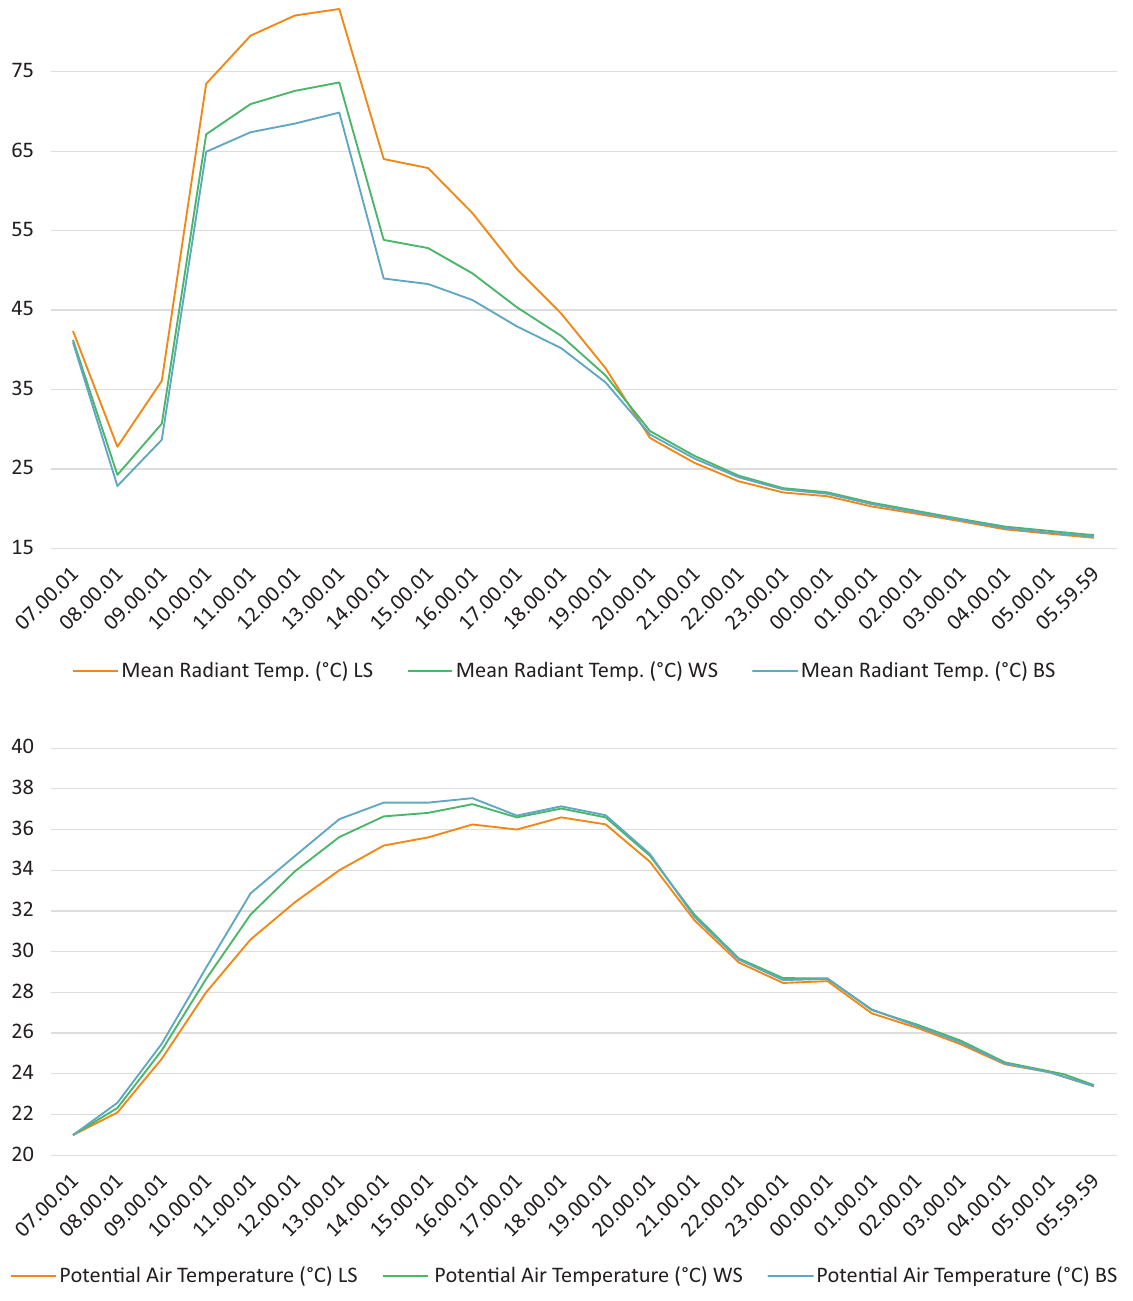
Figure 7. Comparison of the influence of surface albedo on the PAT for an entire day of simulation using ENVI‐met software. Notes: LS = light surface (albedo = 0.8), BS = black surface (albedo = 0.2), WS = wet surface (albedo =